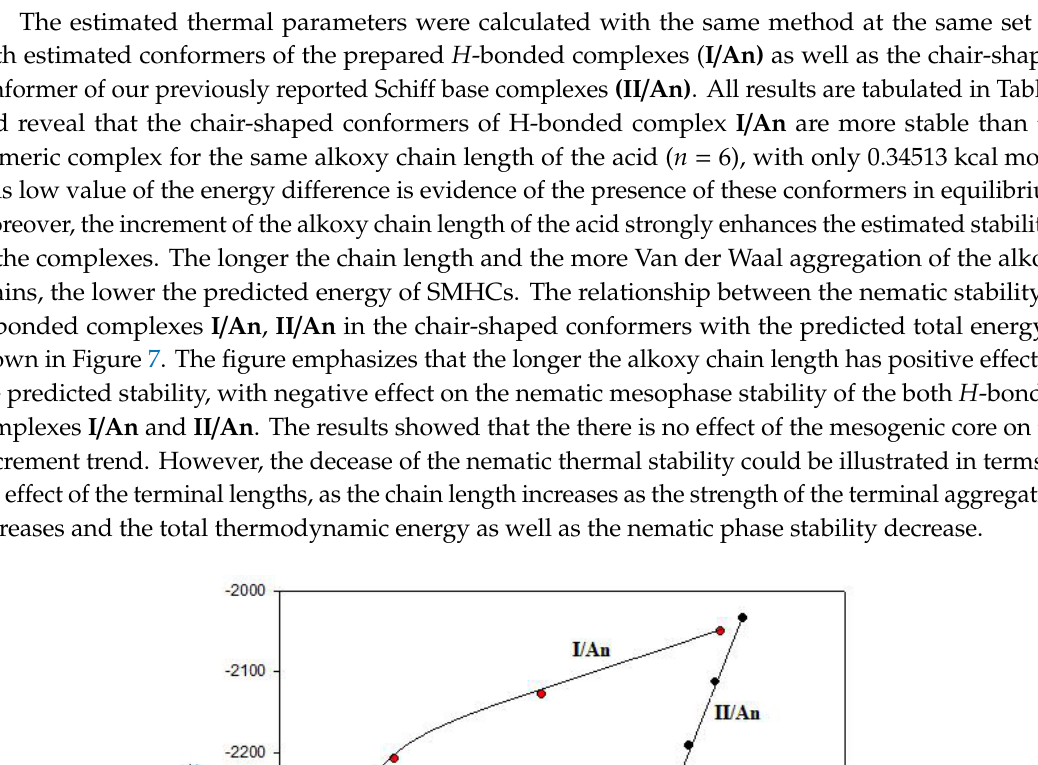
Figure 6. Comparison between SMHB complexes I/An ( ○ ) and II/An (●) in thermal mesophase stability.